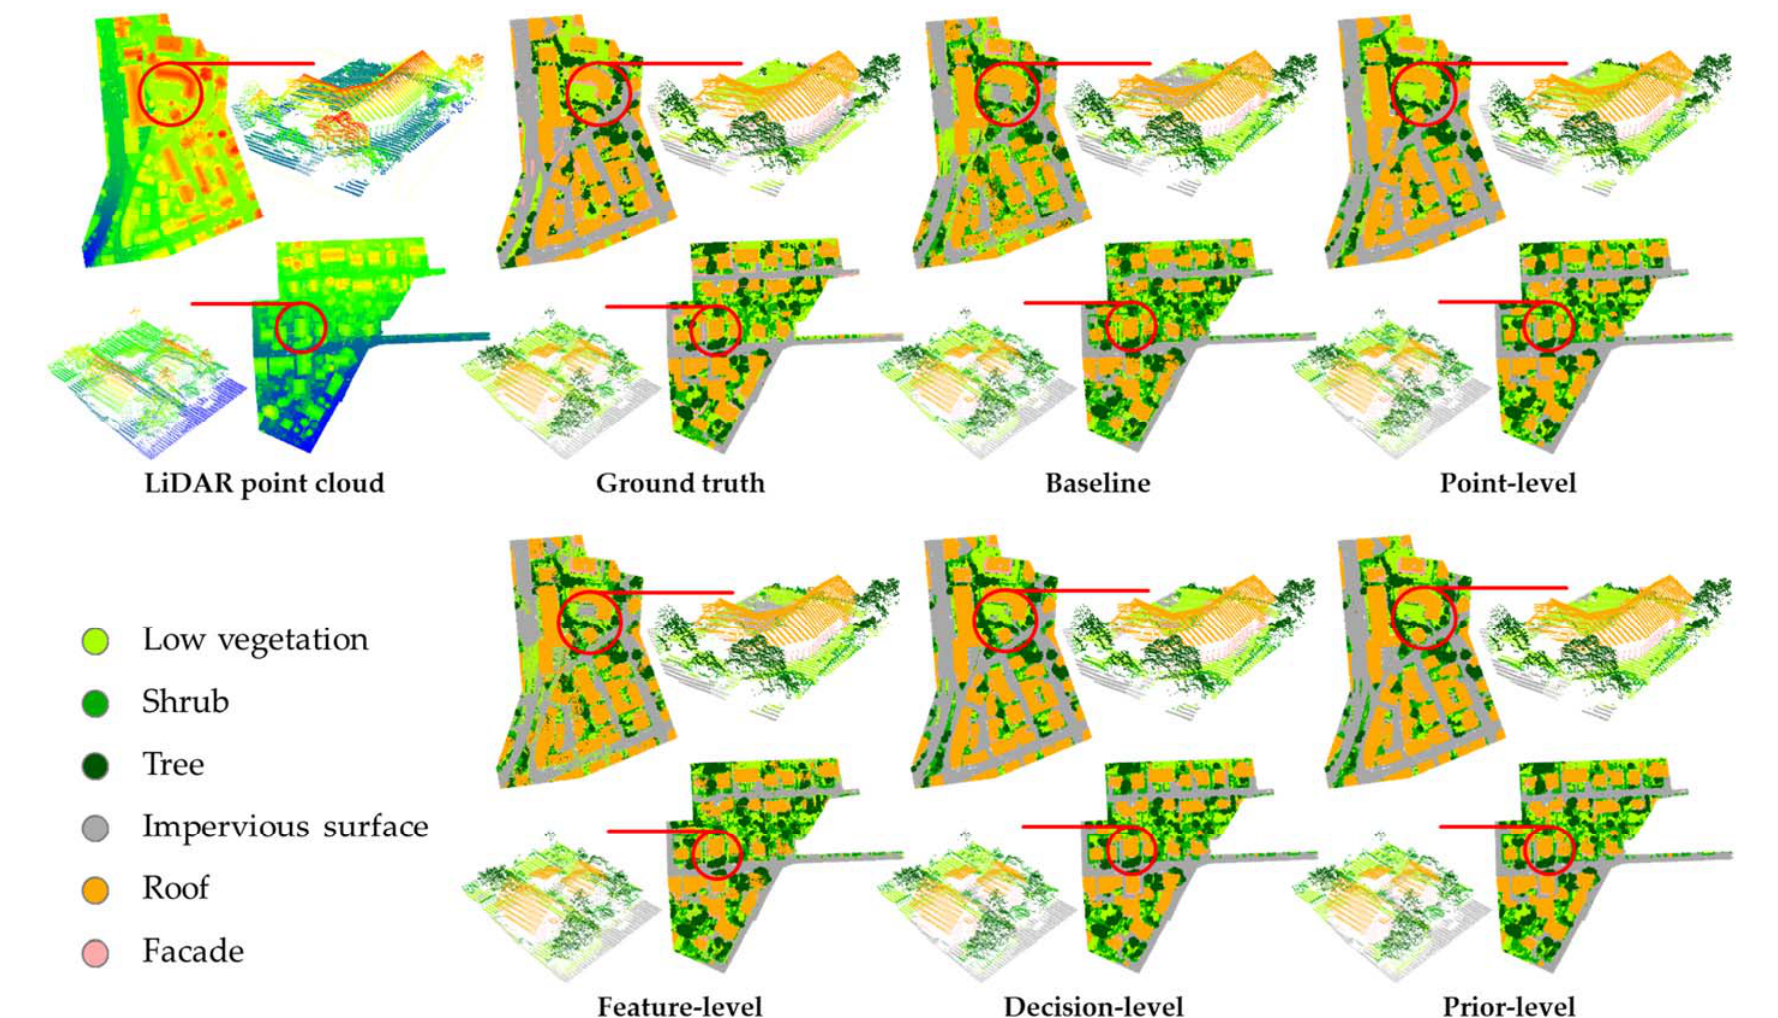
Figure 5. Classification results of the baseline and four fusion strategies. Original data and ground truth are also displayed.